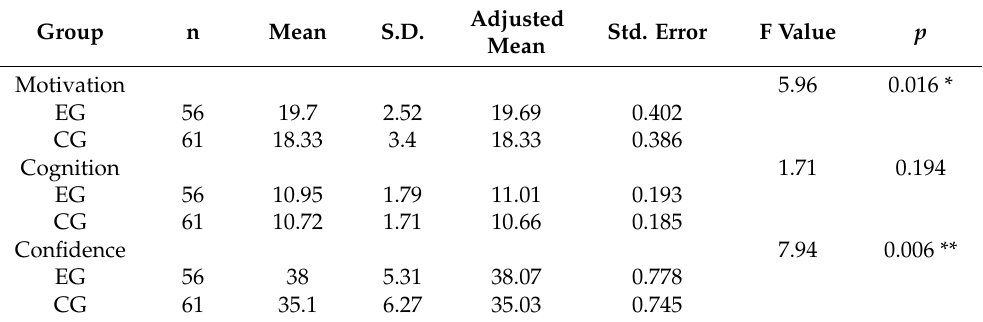
Table 3. Summary of ANCOVA on the follow-up test of motivation, cognition, and confidence between two groups.